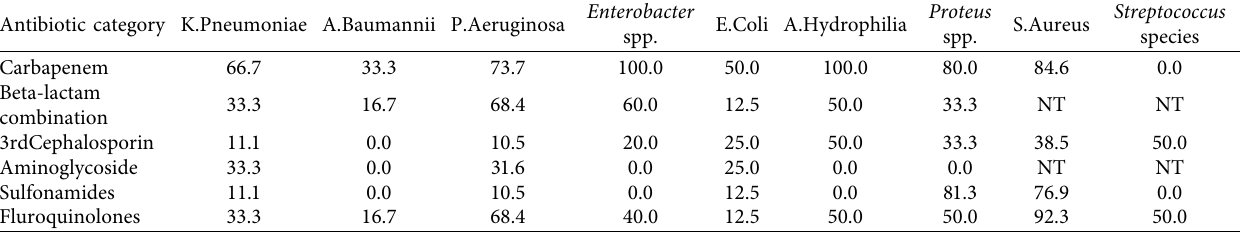
Table 1: Sensitivity patterns of bacteria isolate in percentage. Carbapenem (imipenem/meropenem), β -lactam combination (piperacillin- tazobactam), cephalosporin (ceftazidime/cefotaxime or ceftriaxone for gram-positive bacteria), aminoglycoside (amikacin/kanamycin), Sulfonamides (cotrimoxazole), fuoroquinolones (ciprofoxacin), and penicillin. Te resistant pattern includes an intermediate breakpoint according to CLSI